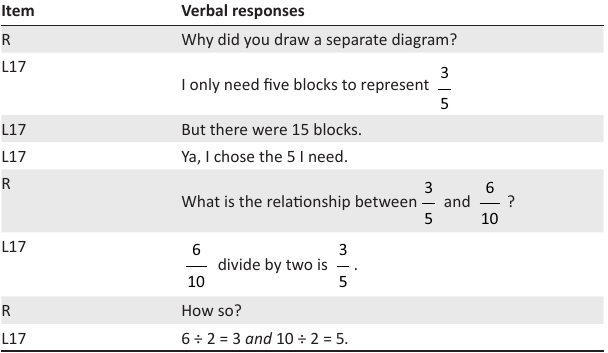
TABLE 7: Verbal response of L17 on Questions 1.3(a) and (b). Item